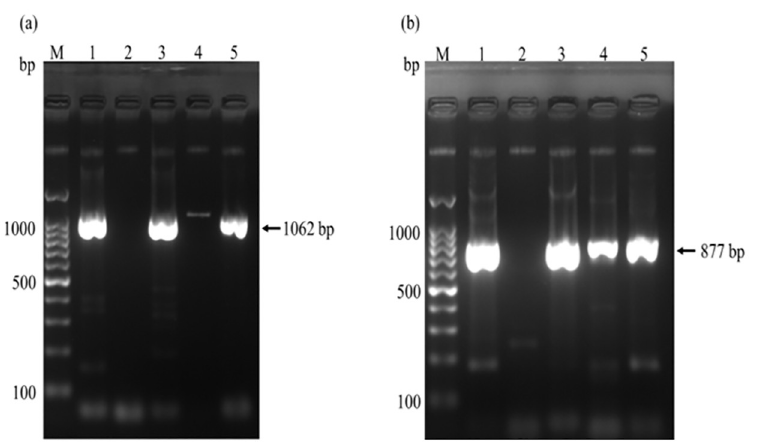
Fig 2. Representative photographs of RT-PCR amplification of VP7 (a) and VP4 (b) genes. Lanes: 1–5, suspected diarrheic stool samples. Successful amplification of VP7 and VP4 genes is seen in lane 1, 3, 5, (a) and lane 1, 3, 4, 5 (b), respectively; M, 100 bp DNA ladder (Promega, USA); The product lengths of VP7 and VP4 genes were 1062 and 877 bp, respectively.